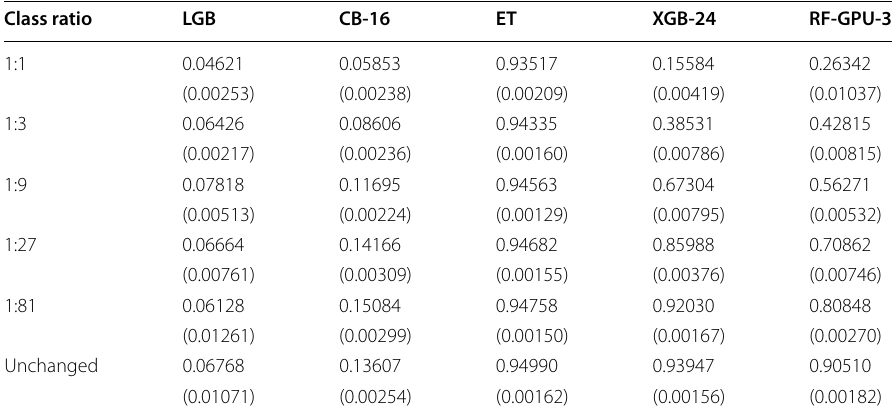
Table 8 Part-B mean and standard deviation of AUPRC with varying levels of RUS (10 iterations of fivefold cross-validation)